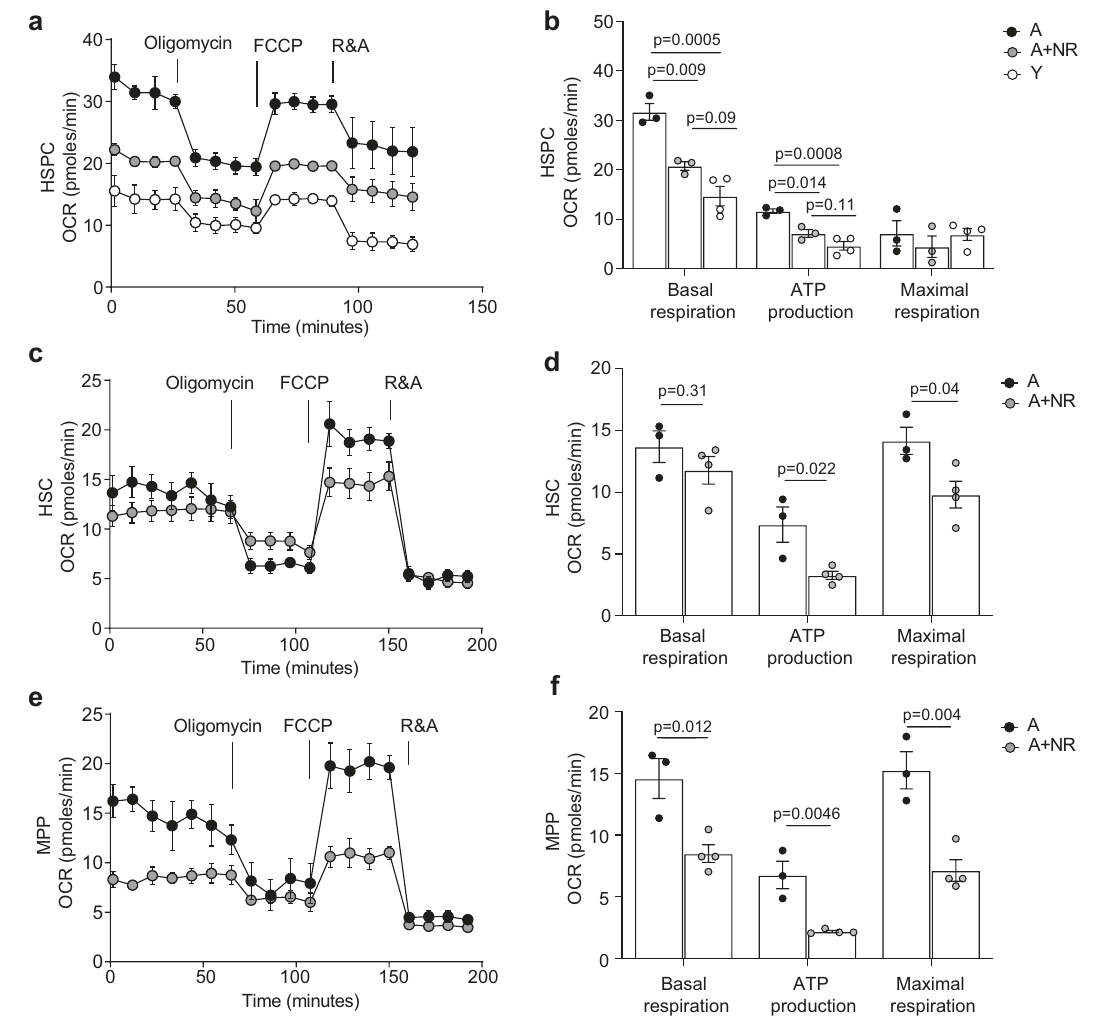
Fig. 4 NR treatment restores youthful metabolism in aged HSC. a Oxygen consumption rate (OCR) in freshly isolated HSPC from aged ( n = 3, biological replicates), NR-treated aged ( n = 3, biological replicates) and young ( n = 4, biological replicates) mice were measured under basal conditions followed by subsequent addition of the ATPase inhibitor oligomycin, the uncoupling reagent FCCP and the inhibitors of the electron transport chain rotenone/ antimycin A (R&A), as indicated. b Basal respiration, ATP production and maximal respiration levels were calculated for HSPC (and throughout